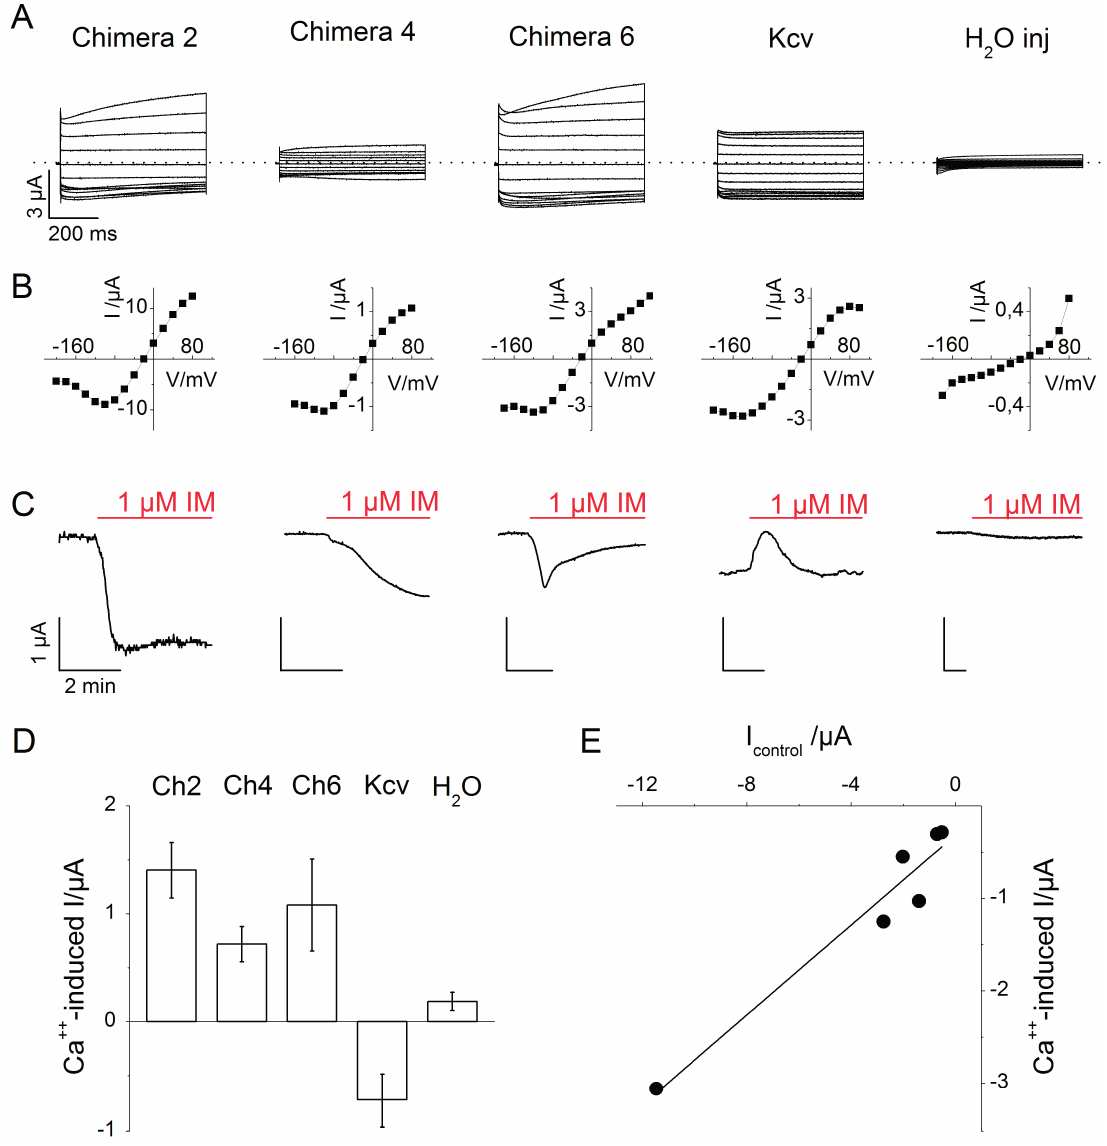
Figure 3. Summary of the main characteristics of the tested chimeras in comparison with Kcv wt and water injected oocytes. ( A , upper row) Whole-cell macro currents recorded from the different constructs by two-electrode voltage clamp. Voltage protocol: from − 200 to +100 mV, in 20 mV steps. ( A , middle row) corresponding I/V curves of the above recordings. ( A , lower row) Representative current traces recorded at − 80 mV before and after (red line) the addition of IM (1 µM) to the external medium; ( B ) Bar graph showing the average current variation induced by IM in the different constructs (Chimera 2, n = 7; Chimera 4, n = 4; Chimera 6, n = 6; Kcv wt, n = 5; water injected, n = 6); ( C ) IM-induced (peak) current increase, plotted as a function of the initial current. Data are shown only for Chimera 6. Measurements performed at − 80 mV. ( D ) Bar graph illustrates the average current variation induced by the increase in cytosolic calcium concentration for the different constructs (N: Ch2 = 7, Ch4 = 4, Ch6 = 6, Kcv = 5, H 2 O = 6); ( E ) IM-induced (peak) current increase, plotted as a function of the initial current. Data are shown only for Chimera 6. Measurement were performed at -80